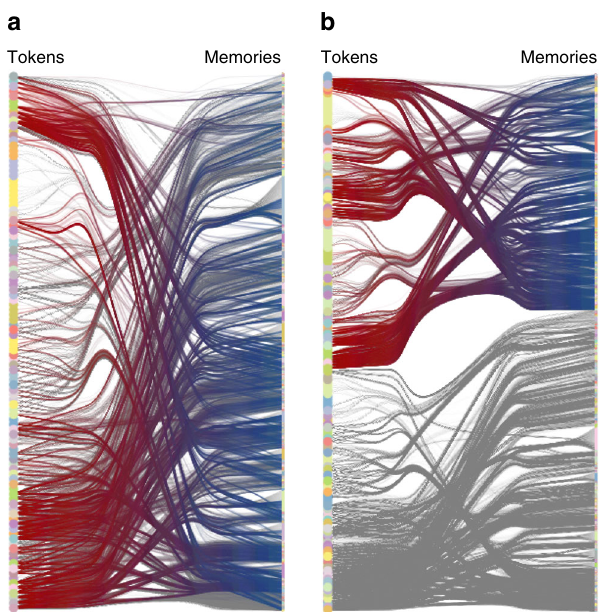
Fig. 6 Markov model fi t for a concatenated text. ‘ The texts are ‘ War and peace ’ by Leo Tolstoy and ‘ À la recherche du temps perdu ’ , by Marcel Proust. Edge endpoints in red and blue correspond to token and memories, respectively, that involve letters exclusive to French. a Version of the model with n = 3 where no distinction is made between the same token in the different novels, yielding a description length (cid:2) log P x t f g ; b ð Þ = 2